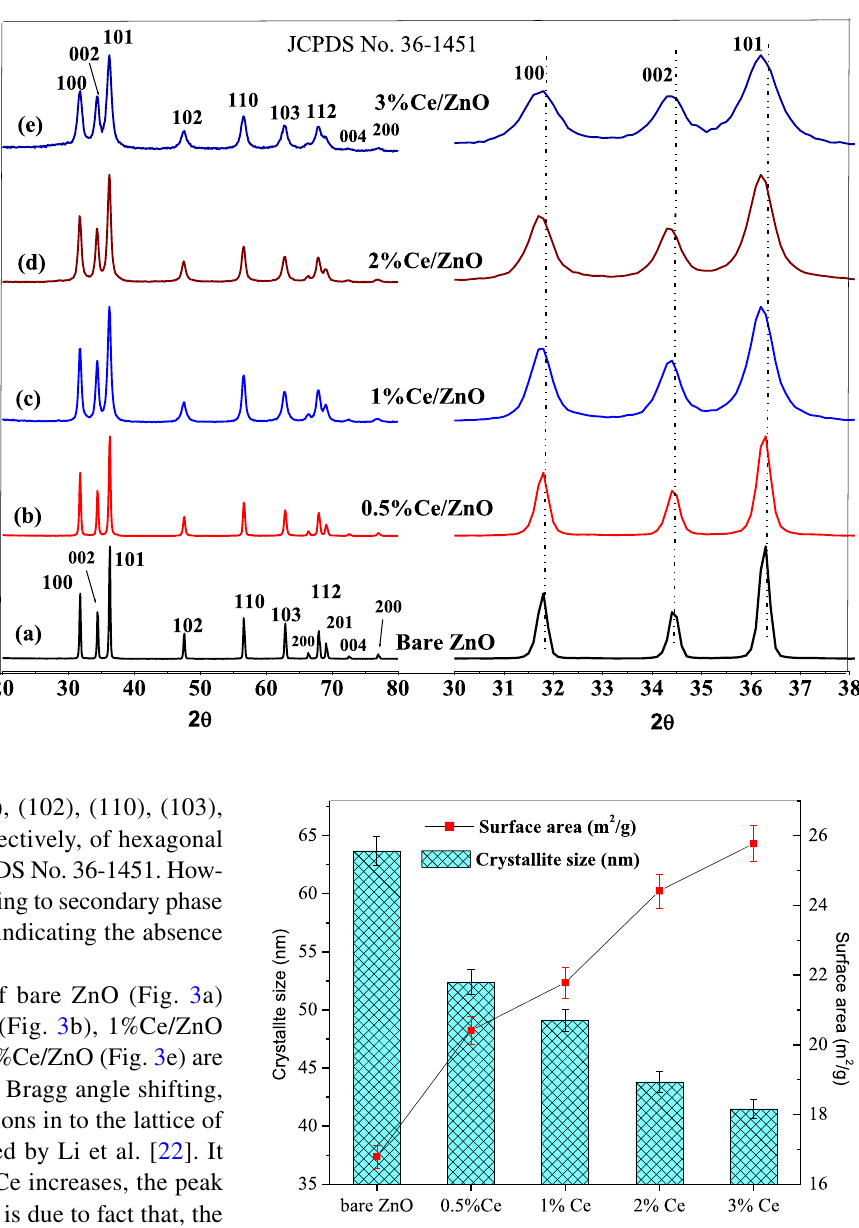
Fig. 3 XRD pattern of a bare